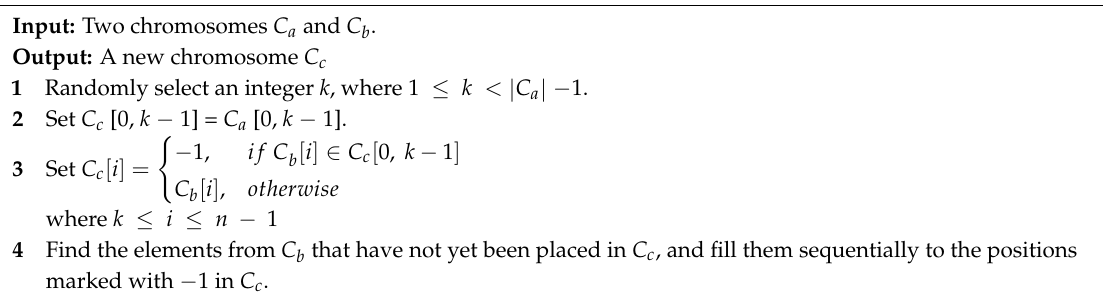
Algorithm 4. Algorithm for chromosomes’ crossover